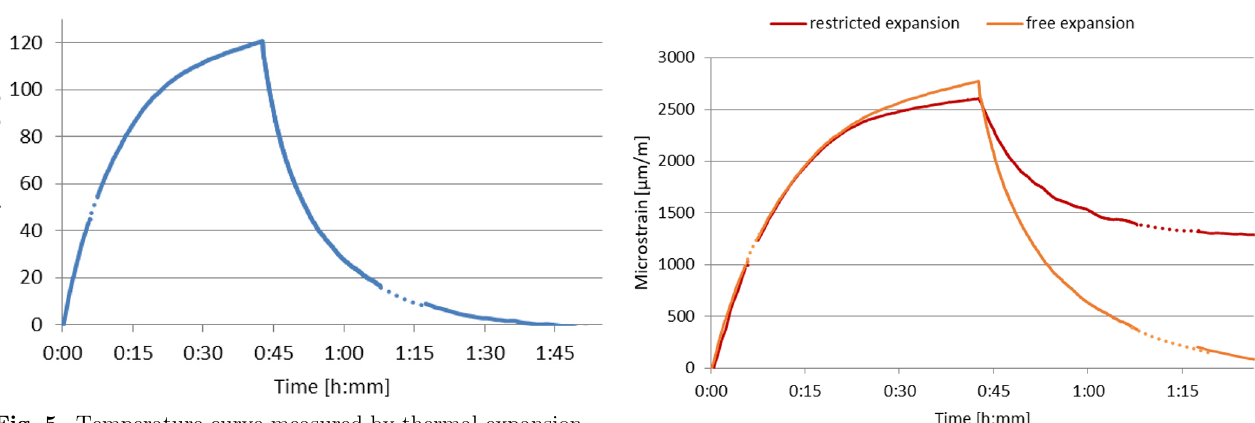
Fig. 5. Temperature curve measured by thermal expansion.